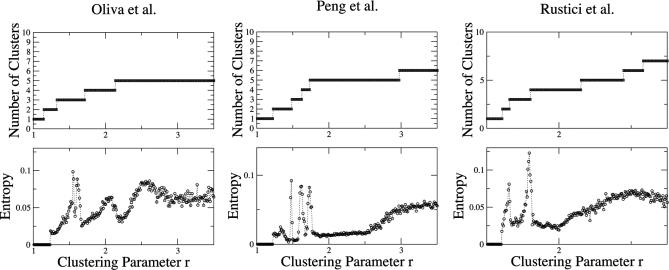
Number of Clusters (Top) and Entropy Landscape (Bottom) as a Function of the Clustering Parameter r, always Given on the x-AxisTop, the y-axis shows the number of clusters identified by the MCL.Bottom, the y-axis shows the clustering entropy S. A peak in the entropy landscape corresponds to an increase in the number of clusters.